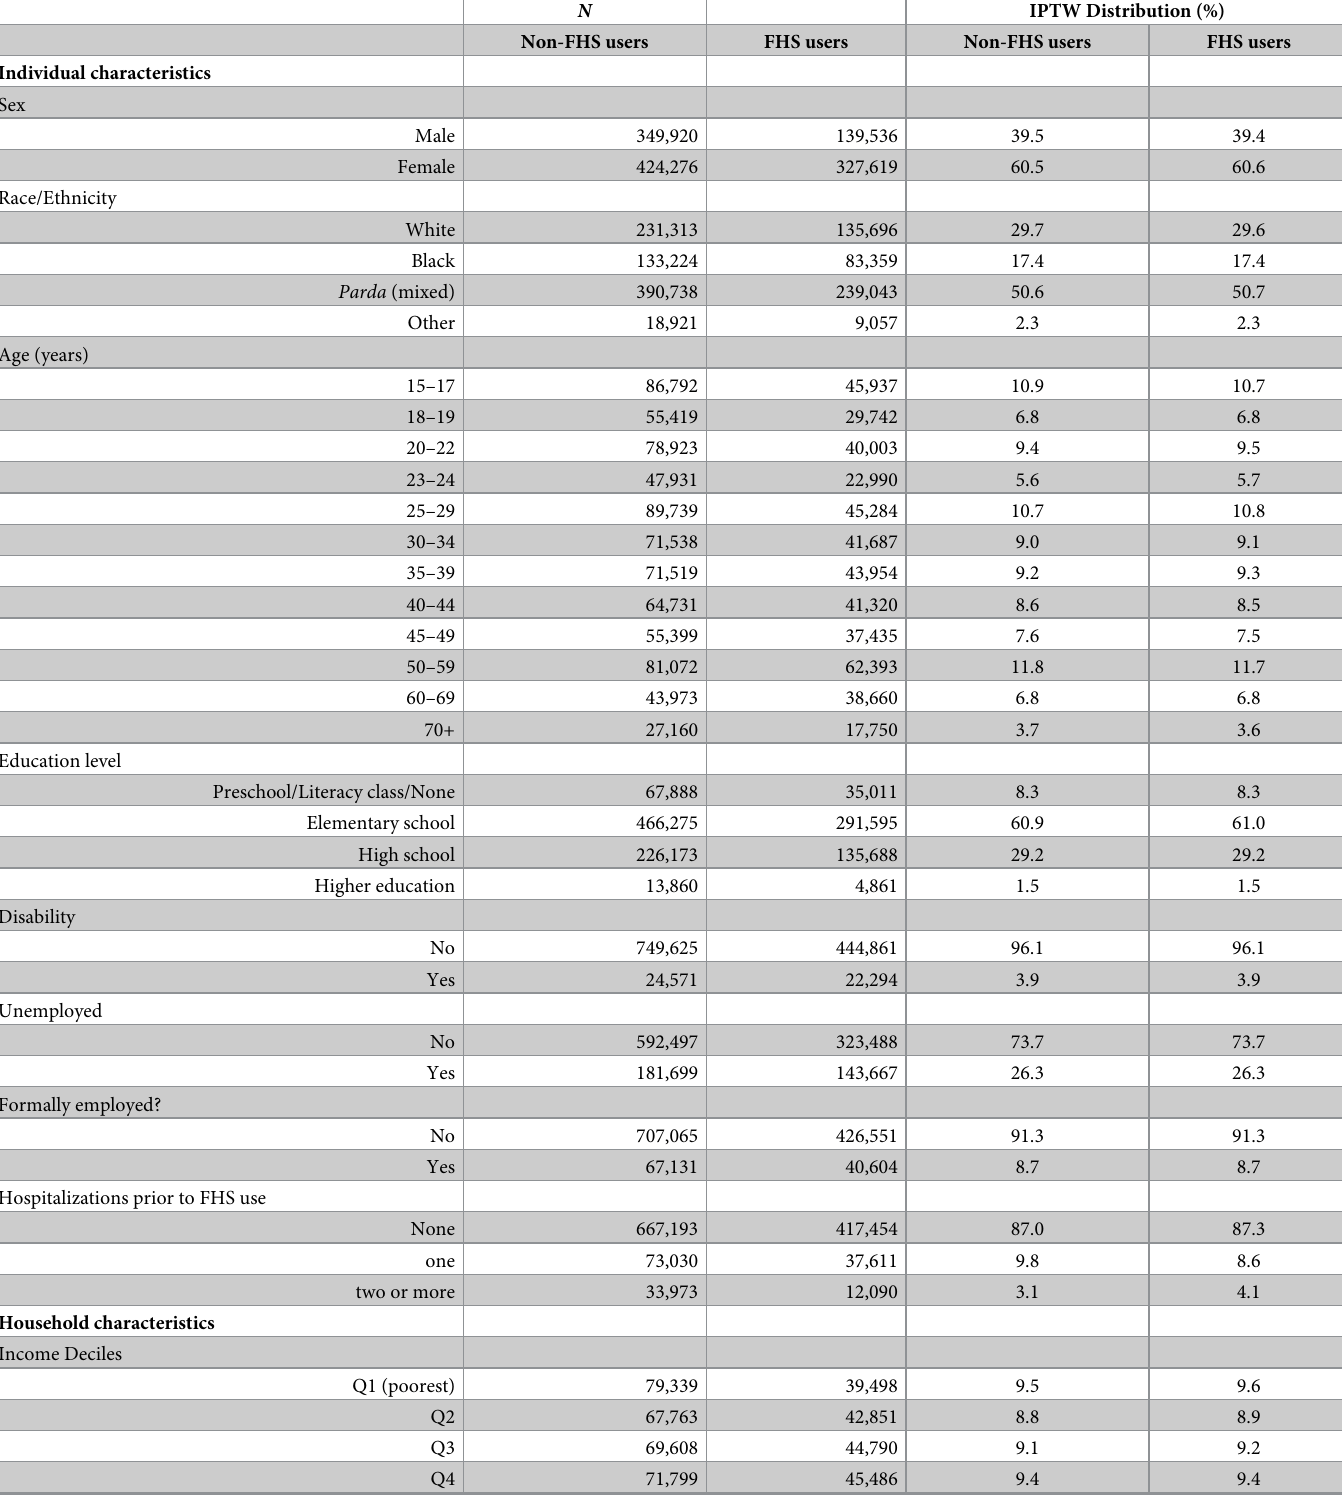
Table 1. Characteristics of cohort by FHS